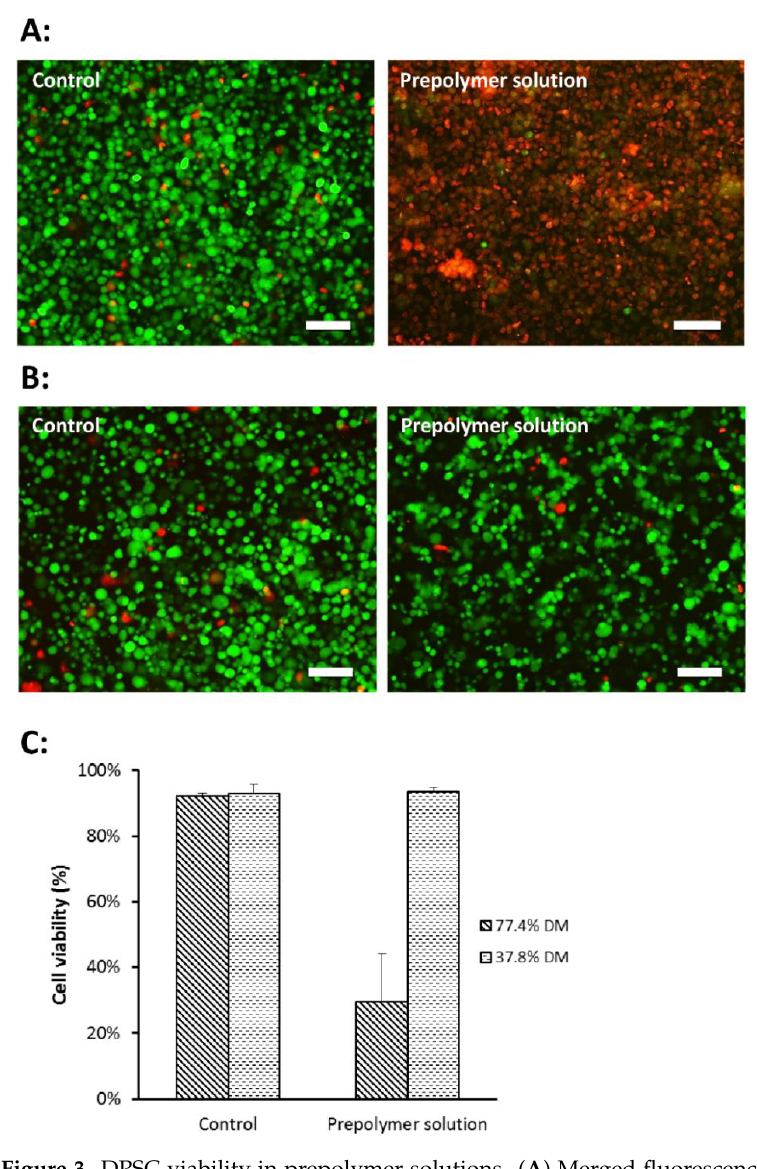
Figure 3. DPSC viability in prepolymer solutions. ( A ) Merged fluorescence images of live/dead assay carried out on cells in control and 77.4% DM MeHA prepolymer solution. Green fluorescence indicates live cells while red fluorescence indicates dead cells. Scale bar represents 100 µm. ( B ) Fluorescence images of live/dead assay carried out on cells in control and 37.8% DM MeHA prepolymer solution. Green fluorescence indicates live cells while red fluorescence indicates dead cells. Scale bar represents 100 µm. ( C ) DPSC viability in control and prepolymer solution of varying DM. Cell viability was calculated by taking fluorescence intensity of live cells over total fluorescence intensity of live and dead cells. Each data point represents the mean ± SD ( n = 4). Cell viability was 92.4 ± 0.9% and 29.6 ± 1.5% in the control and prepolymer solution, respectively, for 77.4% DM MeHA. Cell viability was 93.0 ± 2.6% and 93.4 ± 1.4% in the control and prepolymer solution, respectively, for 37.8% DM MeHA. (SD = standard